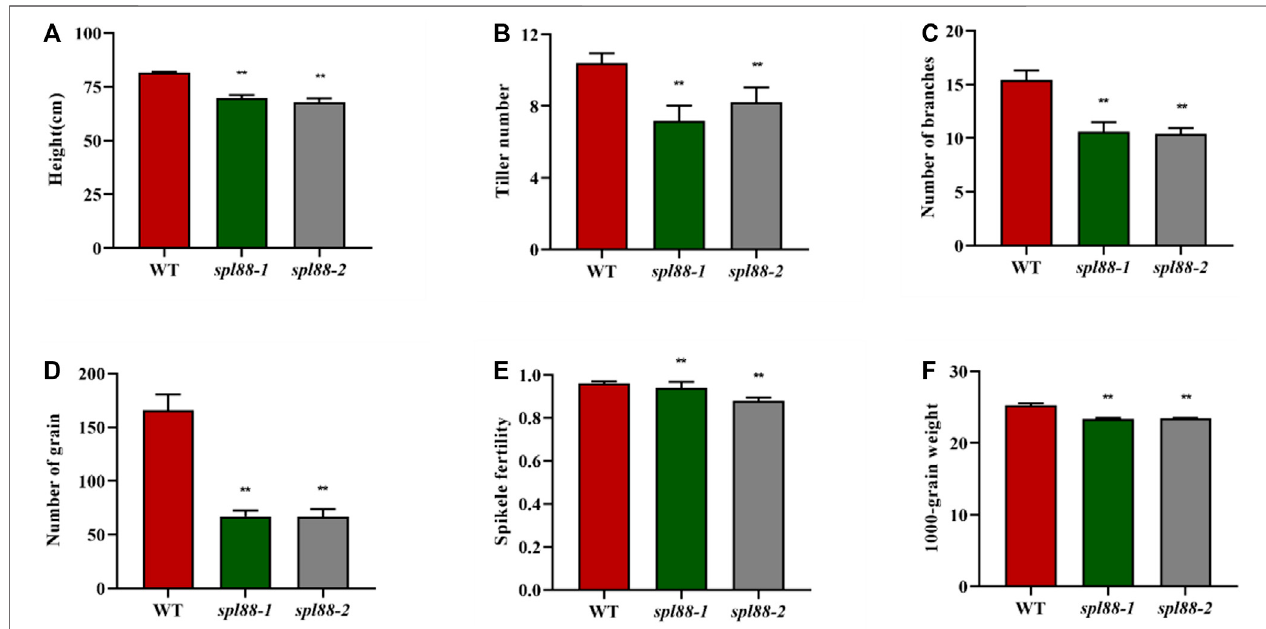
FIGURE 2 | Main agronomic traits of wild-type and mutant plants. (A) : plant height; (B) : tiller number; (C) : number of branches; (D) : number of grain; (E) : spikele fertility; (F) : 1000-grain weight; values are means ± SD (n = 10); * indicates signi fi cance at p ≤ 0.05 by Student ’ s t test; ** indicates signi fi cance at p ≤ 0.01 by Student ’ s t